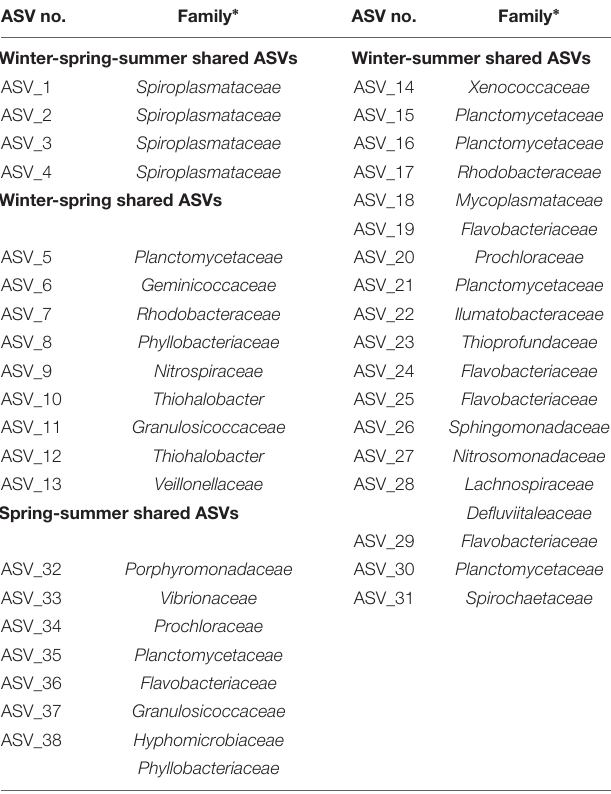
TABLE 1 | ASVs sharing among C. viridis -associated microbial communities in winter, spring, and summer. ASV no. ASV